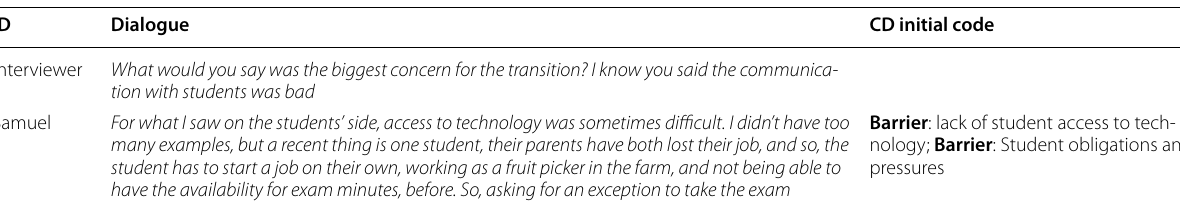
Table 3 First (open) cycle